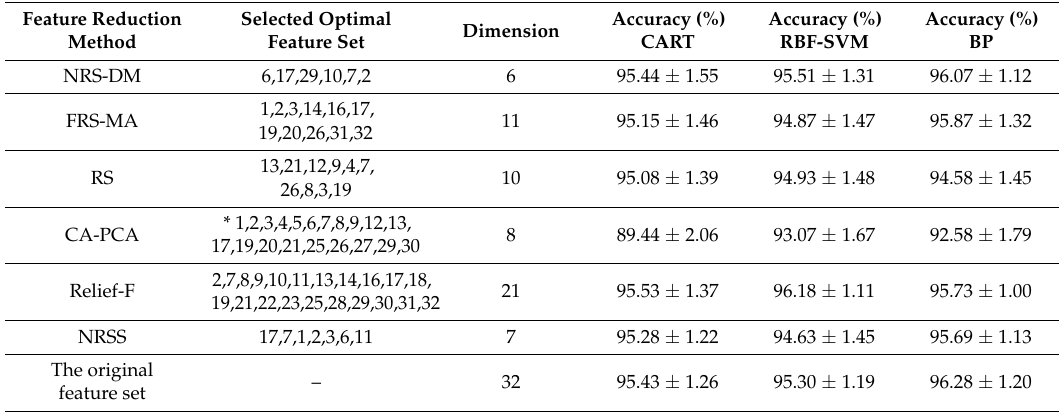
Table 4. Results in the condition of N -1 contingencies (NES39).